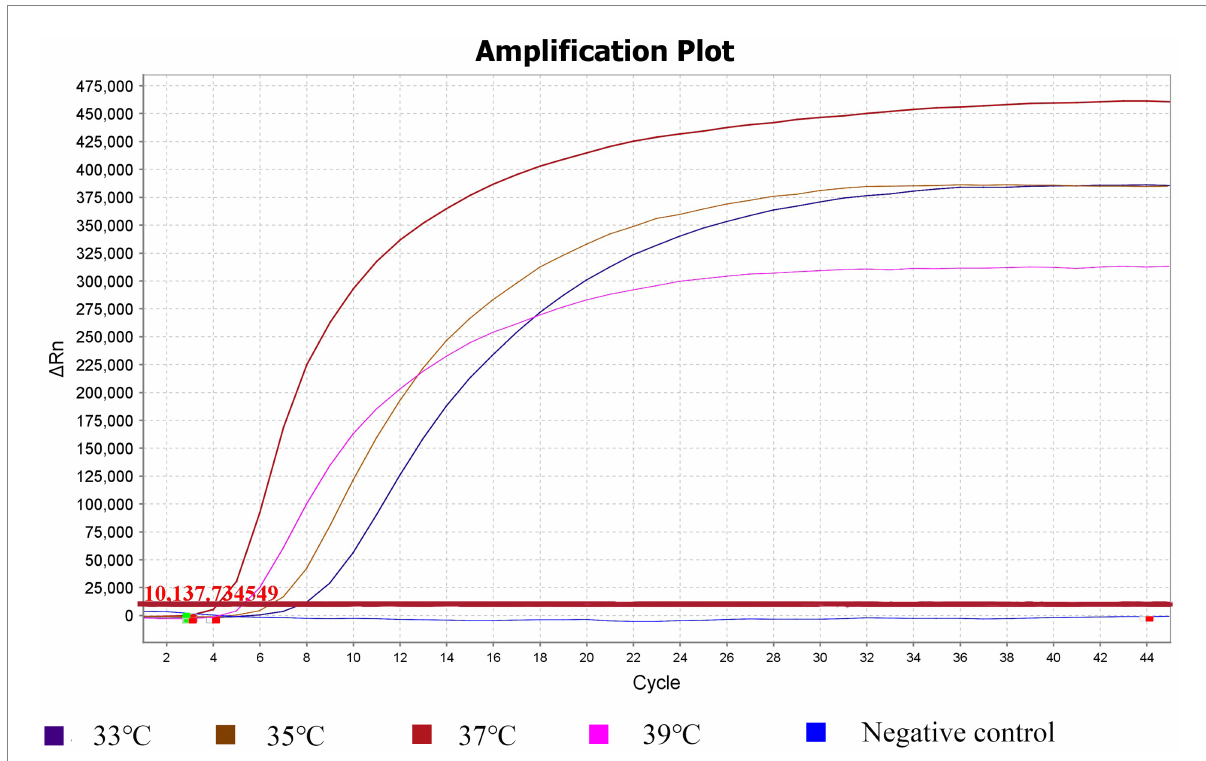
FIGURE 1 Temperature optimization for the RPA assay. RPA assay was conducted at a broad range of amplification temperatures (33 ° –39 ° C) to analyze the optimal reaction temperature for RPA